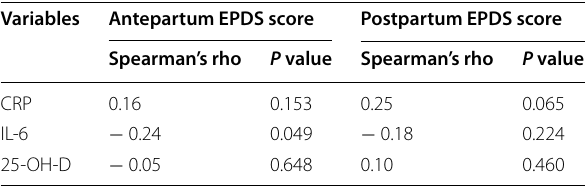
Table 3 Biomarkers association with antepartum and postpartum EPDS score